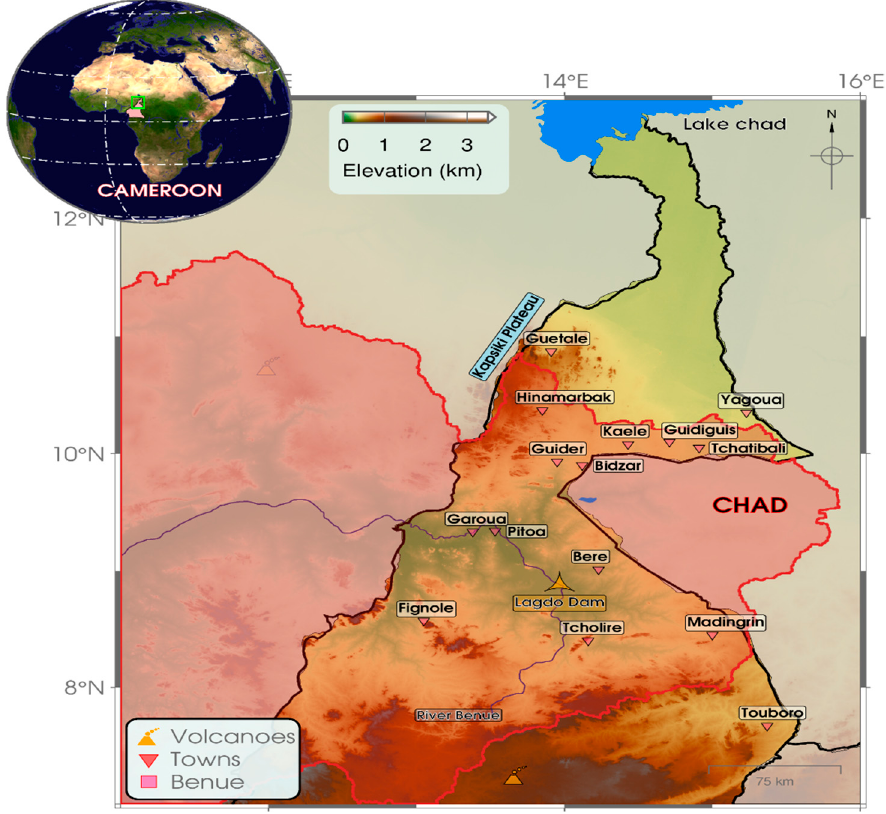
Figure 1. Map of the study area with the Sudano-Sahelian political border of Cameroon, topography and selected rainfall stations. Red line delineates the water catchment boundary. Table 1. Geographical descriptions of the data, altitude, period of measurement, and percentage of missing